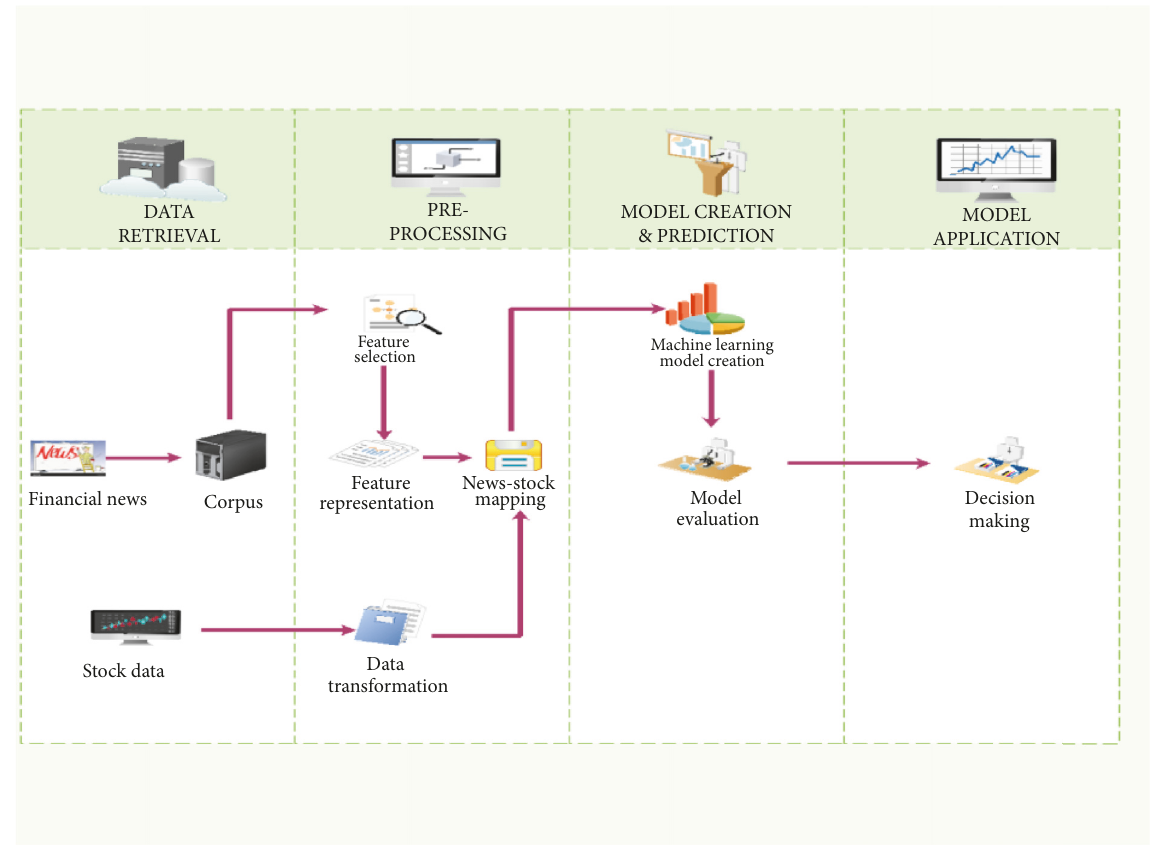
Figure 1: Research workflow for machine learning and knowledge graph.